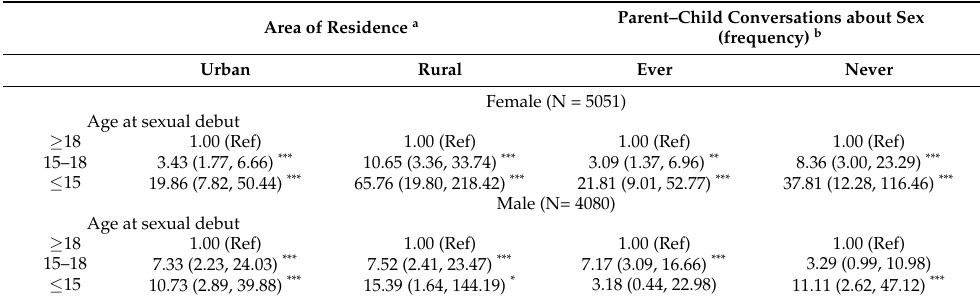
Table 4. The associations between SAs and age at sexual debut by sex, area of residence, and parent–child communication about